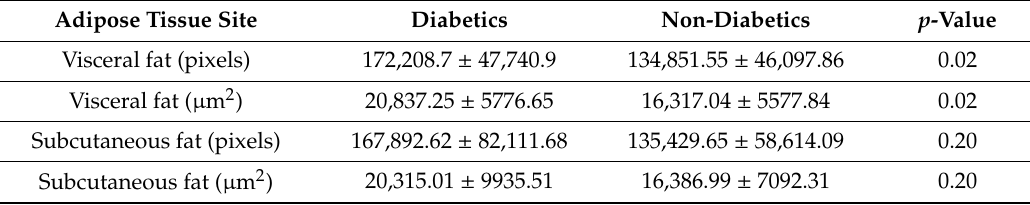
Table 9. Comparison of the adipocyte cell size between diabetics and non-diabetics. Adipose Tissue